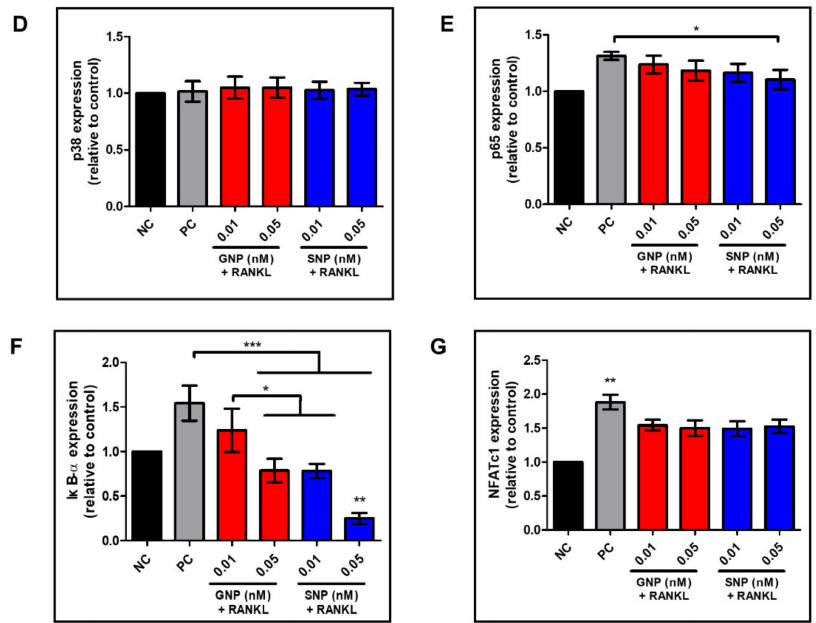
Figure 6. BMMs of the NC group were cultured with CM. BMMs were differentiated into osteoclasts with CCM for five days. The protein expression levels at various concentrations of GNPs or SNPs were measured. Immunoblotting was used to detect the phosphorylation (p) form and the total (t) form of ERK, JNK, p38, p65, and I κ B α (nuclear factor of the kappa light polypeptide gene enhancer in the B-cell inhibitor, alpha). The phosphorylation (p) form of NFATc1 was examined by immunoblotting. ( A ) Representative band images of mitogen-activated protein kinase (MAPK) (ERK, JNK, and p38) and NF- κ B (I κ B α , p65) signal pathways, NFATc1, and β -actin. Quantitative analysis of ( B ) p-ERK/ERK, ( C ) p-JNK/JNK, ( D ) p-p38/p38, ( E ) p-p65/p65, ( F ) p-I κ B α /I κ B α , and ( G ) NFATc1/ β -actin. Quantitative volumes are expressed as the mean ± SD ( n = 3 per group). “*” indicates a significant difference for which p < 0.05. “**” indicates a significant difference for which p < 0.01. “***” indicates a significant difference for which p <